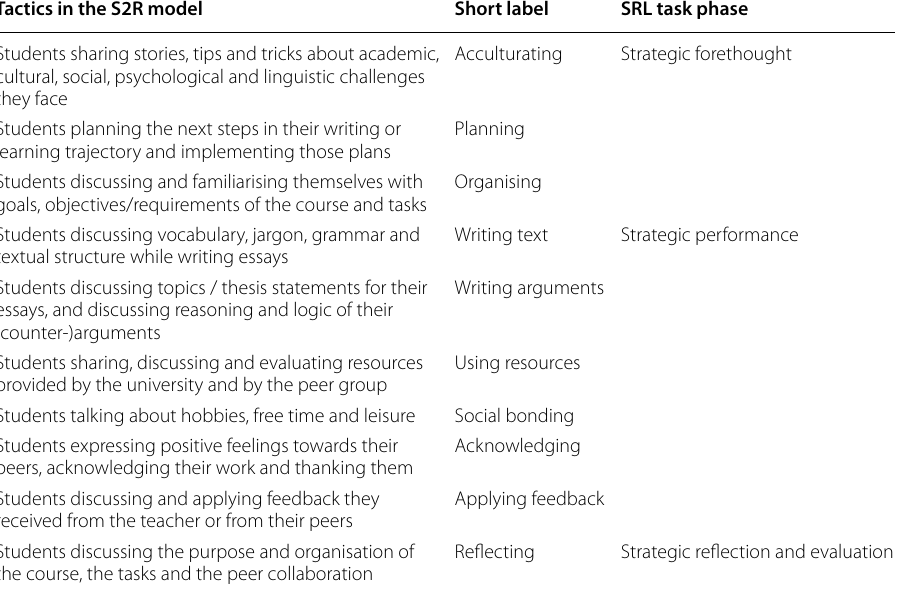
Table 2 Overview of tactics and S2R task phases in the data set Tactics in the S2R